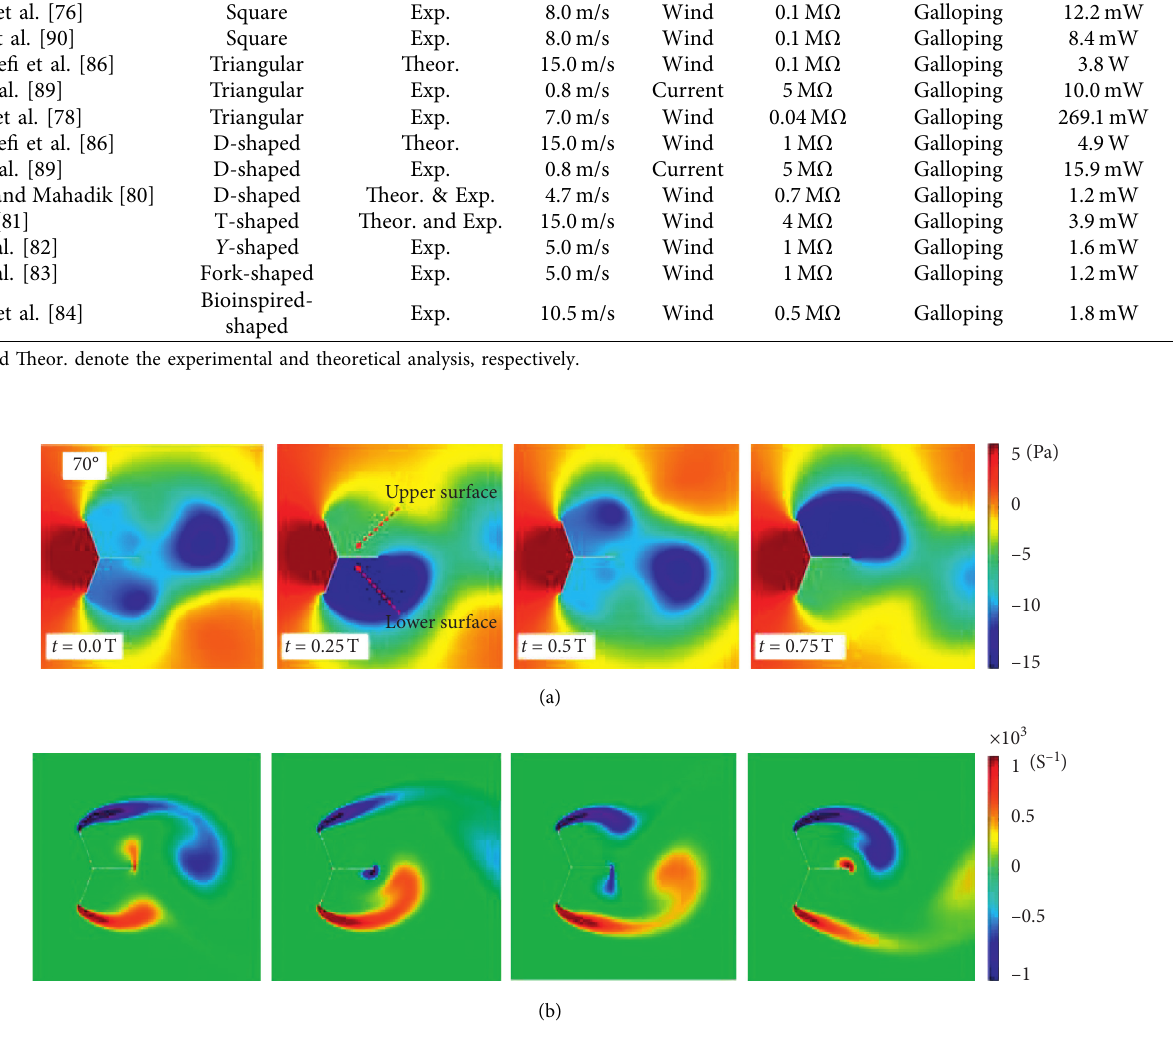
Figure 9: (a) Pressure distribution. (b) Vorticity contours of Y -shape bluff body